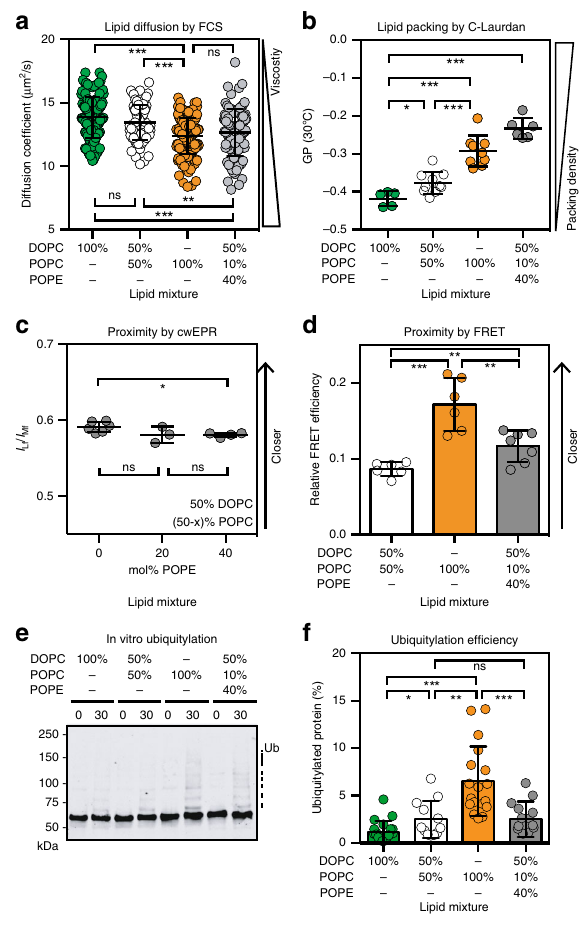
FRET ef fi ciency (Fig. 5f) of the reporter were low when the sensor was situated in a bilayer with poorly packing Δ 9- cis acyl chains (Figs. 3f, g and 5e, f). This indicates a relatively large distance between the binding site for Rsp5 (K969) and the target site for ubiquitylation in the opposing protomer of Mga2 (K983). The FRET ef fi ciency was only mildly higher in a membrane environment with Δ 6- cis acyl chains (Fig. 5f). This suggests that the position of the cis double bond has only a modest impact on the average distance between K969 A and K983 D in the FRET reporter. Signi fi cantly higher FRET ef fi ciencies were observed when the reporter was placed in membranes with tightly packing Δ 9- trans 18:1 acyl chains (Fig. 5f) or Δ 9- trans 16:1 acyl chains (Supplementary Fig. 5g, h). These fi ndings demonstrate that the structural dynamics of Mga2 is affected by the con fi guration and potentially by the position of double bonds in unsaturated lipids.